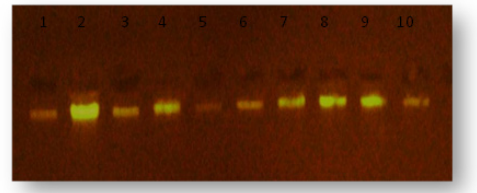
Fig. 2. Electrophoresis pattern of PCR product of miR- Fig. 1. Electrophoresis pattern of gnomic DNA in study 146a gene, , lane 2-10 for patients, lane 11-16 for control, groups, lane 1-5 DNA from patients lane 6-10 DNA DNA marker (195 from control table 1. The genotype distribution and odd ratio of